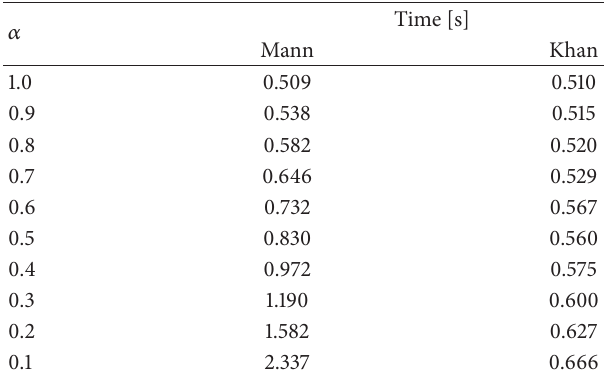
Table 3: Times of polynomiograph’s generation for 𝑝 2 using one parameter iterations.